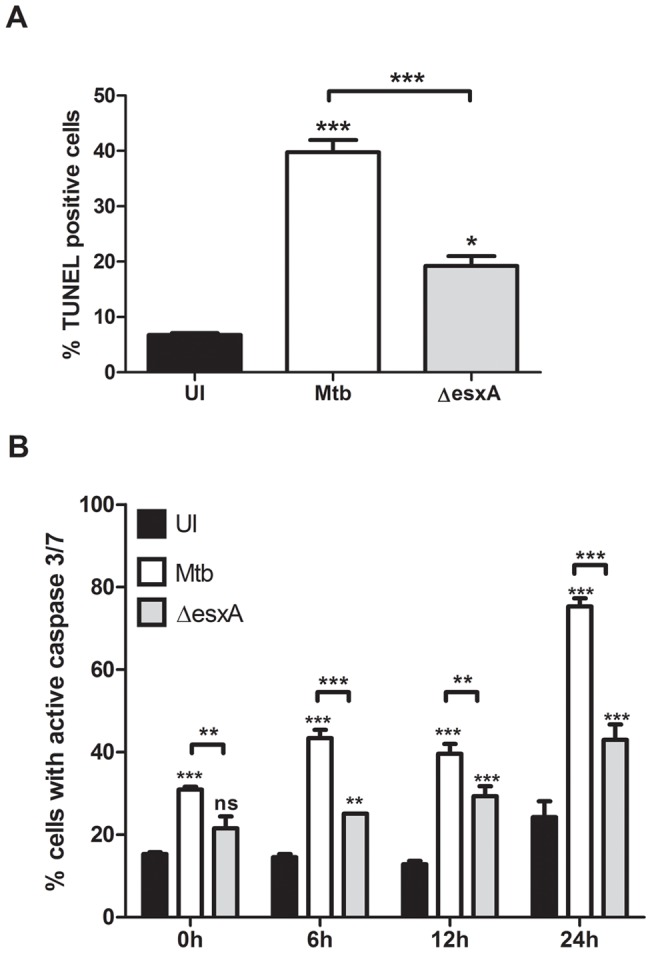
The ESX-1 secretion system of Mtb mediates induction of apoptotic host cell death.(A) BMDCs were left uninfected (UI), infected with wild-type Mtb (Mtb) or the esxA deletion mutant (ΔesxA) for 4h at MOI of 10, washed and incubated for an additional 24 h. Cells were harvested and stained using the TUNEL assay. The percent of TUNEL positive cells was determined by flow cytometry. (B) BMDCs were infected as described for (A) and then chased for the indicated time periods. The percentage of cells with active caspase-3/7 was detected as described in material and methods. Shown are means and standard deviation of triplicate measurements of one representative experiment out of three.